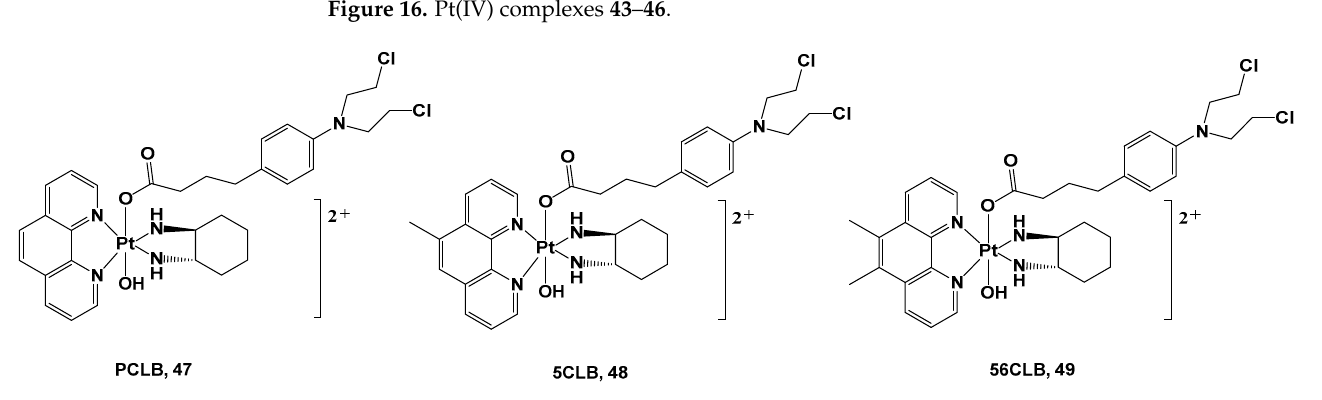
Figure 16. Pt(IV) complexes 43 – 46 .